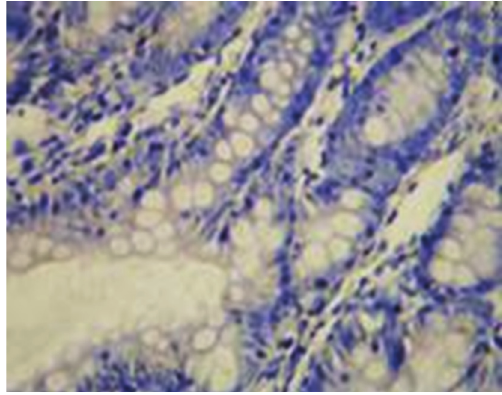
Figure 7: sham-operated group-21d mucous membrane of small intestine ( − ) Bax × 200.